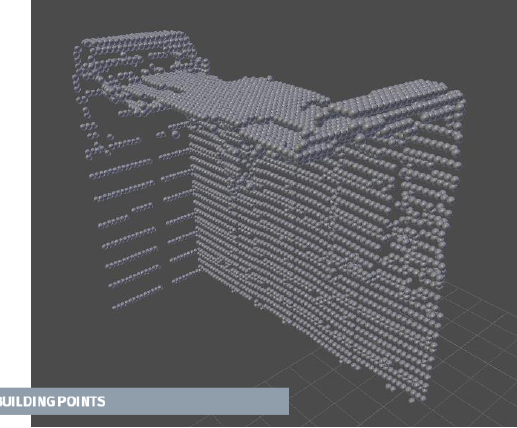
Figure 9. Generated Solar Irradiation Model Screenshot